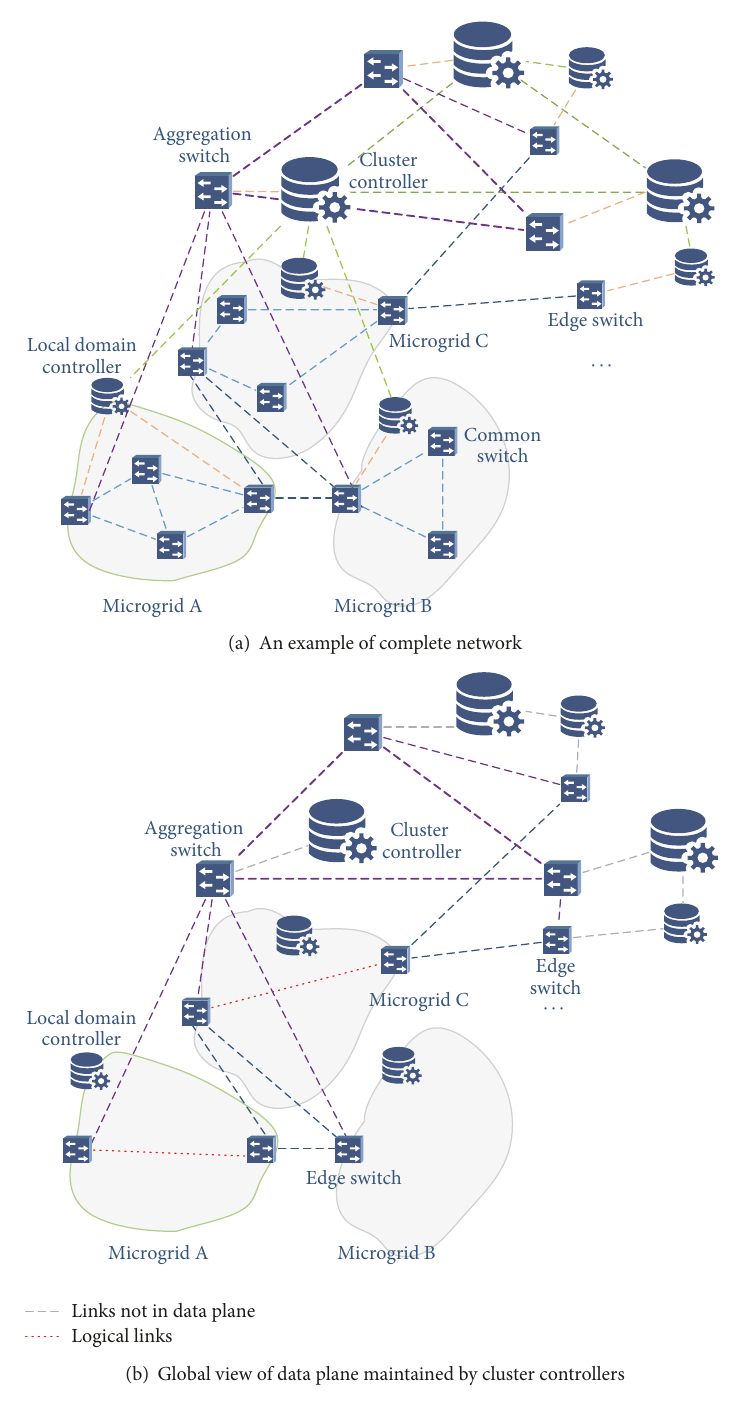
Figure 7: A case of SDN-enabled hierarchical architecture in energy